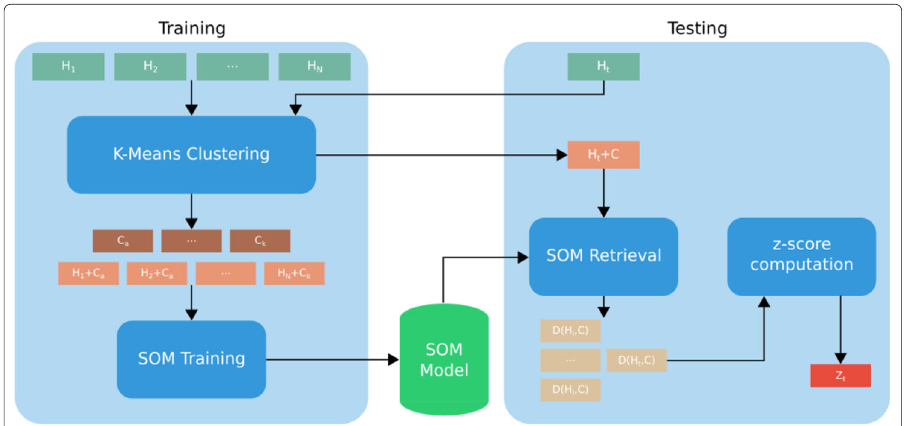
Fig.7 Overview of the anomaly detection process. First the histograms from the training dataset are clustered using k-means, and fed to a Self-Organizing Map. The histogram corresponding to the tested transaction is compared with the model, and its similarity with the other histograms from its cluster is